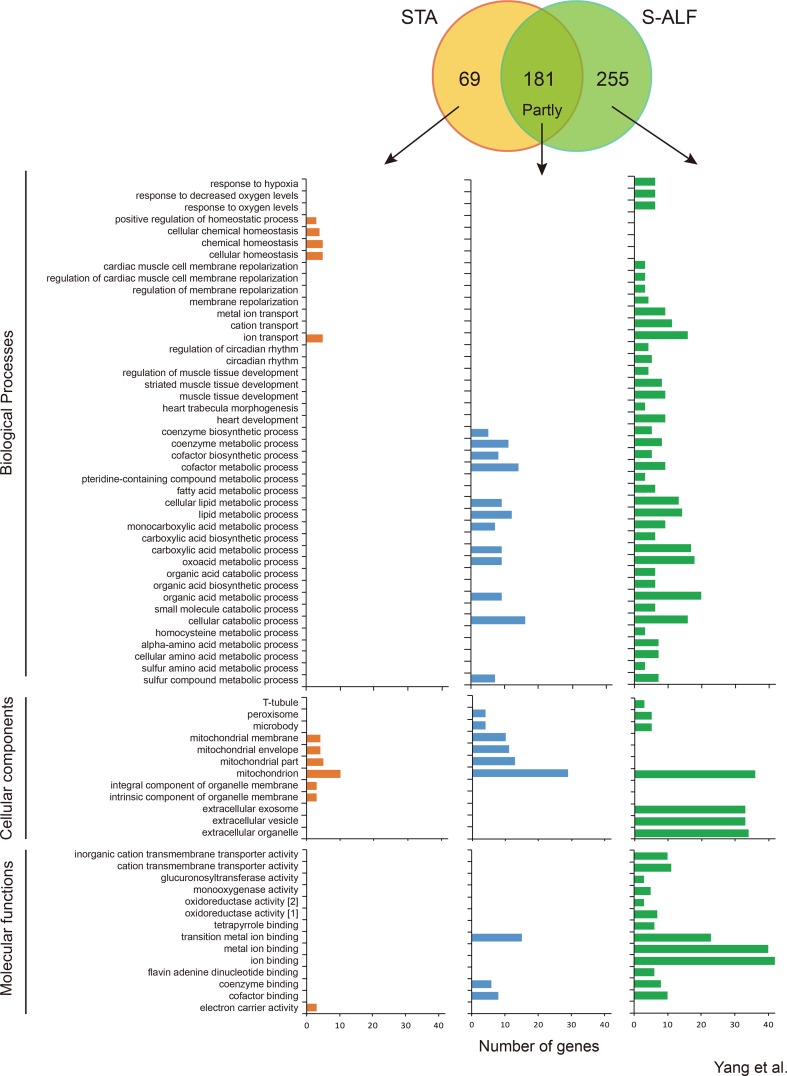
Number of genes and Gene Ontology term enrichment of the U-N pattern in lambs fed the starter diet with (S-ALF) or without alfalfa intervention (STA) during early life. [1] = oxidoreductase activity, acting on paired donors, with incorporation or reduction of molecular oxygen; [2] = oxidoreductase activity, acting on paired donors, with incorporation or reduction of molecular oxygen, NAD(P)H as one donor, and incorporation of one atom of oxygen.